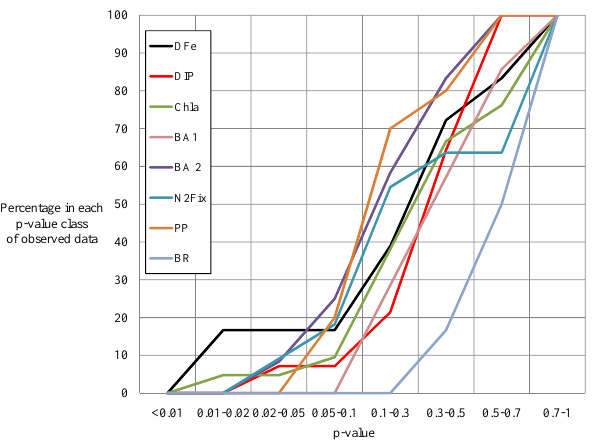
Figure 14 Fig. 14. The cumulative (in %) distribution function of the p -values computed from t -test comparing CONTROL and OUTSIDE data (labels: same as in Fig. 13 and “BR”: bacteria respiration).